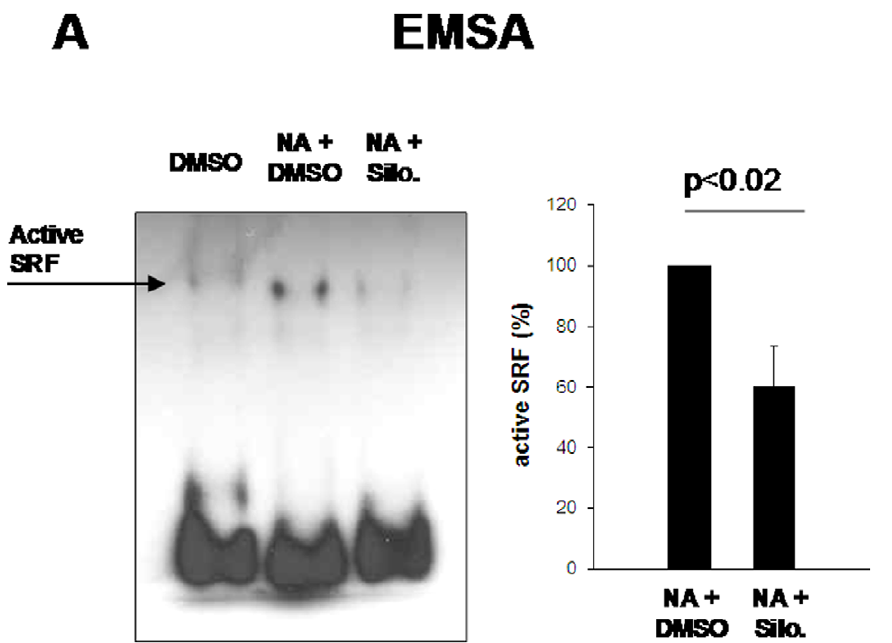
Figure 6. Inhibition of NA-induced SRF activation by silodosin. Prostate tissue from each patient was allocated to three samples, which were stimulated with NA (30 m M) for 15 min, or remained unstimulated. Silodosin (3 m M) or solvent (3 m l DMSO) were added 15 min before NA as indicated. All samples were exposed for identical total periods to experimental conditions to prevent agonist-unspecific effects. In each experiment, SRF in NA-stimulated samples without silodosin (=DMSO) was set to 100%, and values for samples with silodosin were referred to that sample. Shown are representative experiments, and densitometric quantification of all experiments (n=6 patients; means 6 SEM). may represent the conditions in the hyperplastic prostate. Of note, all investigated samples.